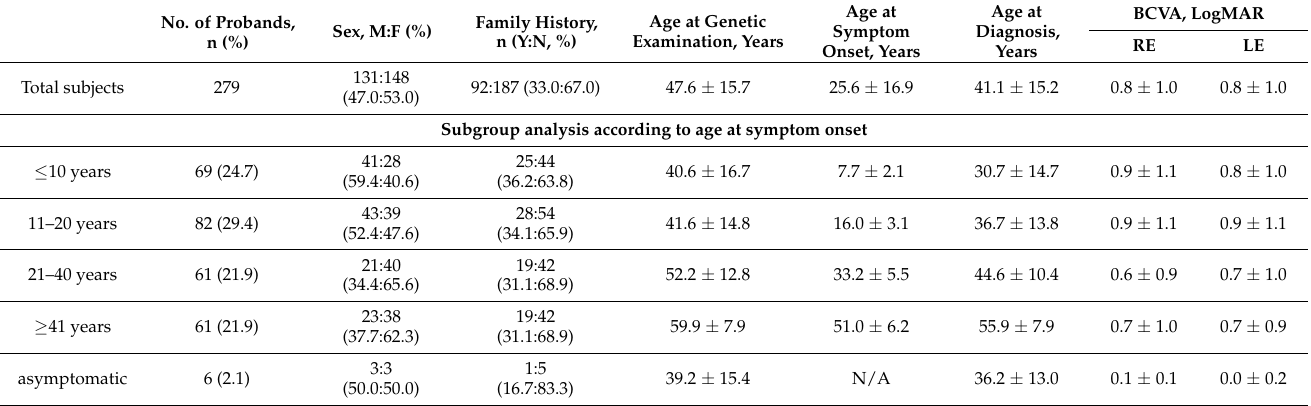
Table 1. Baseline clinical characteristics of probands with retinitis pigmentosa and subgroup analysis based on age at symptom onset.